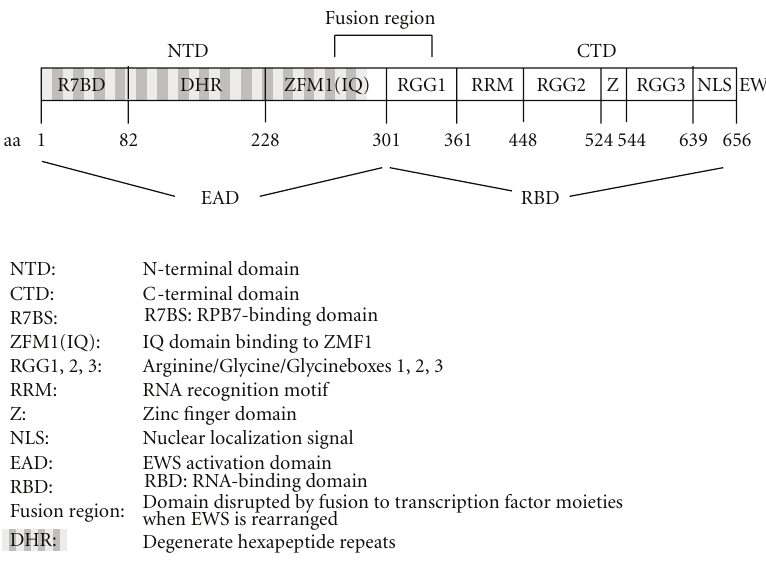
Figure 1: Structure of the prototype FET protein